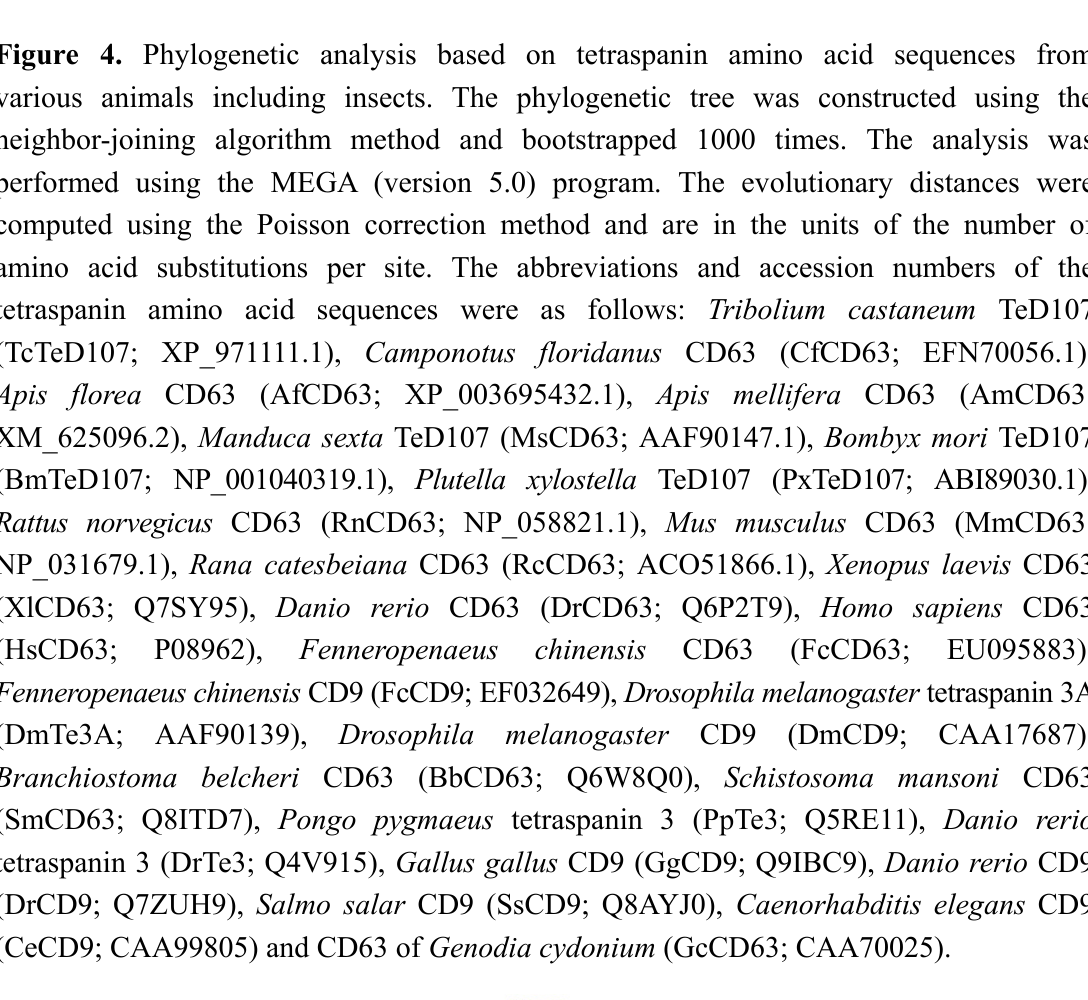
Figure 4. Phylogenetic analysis based on tetraspanin amino acid sequences from various animals including insects. The phylogenetic tree was constructed using the neighbor-joining algorithm method and bootstrapped 1000 times. The analysis was performed using the MEGA (version 5.0) program. The evolutionary distances were computed using the Poisson correction method and are in the units of the number of amino acid substitutions per site. The abbreviations and accession numbers of the tetraspanin amino acid sequences were as follows: Tribolium castaneum TeD107 (TcTeD107; XP_971111.1), Camponotus floridanus CD63 (CfCD63;